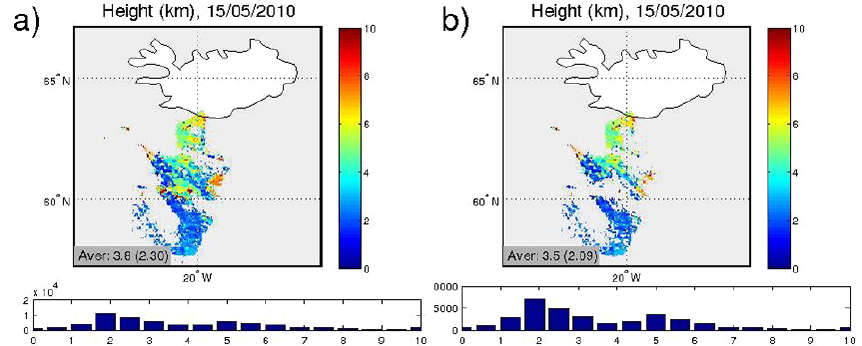
Figure 8. Eyjafjallajökull eruption 15 May 2010. We show the effect of removing the ash pixels flagged as cloudy by 659nm reflectance cloud test. In panel (a) we show all SPH values, while in panel (b) the cloud-flagged pixels have been removed. The average height decreases from 2.40 to 2.29km when the clouds are removed, but the height histograms (below the maps) show that there are no dramatic changes in the height distribution.